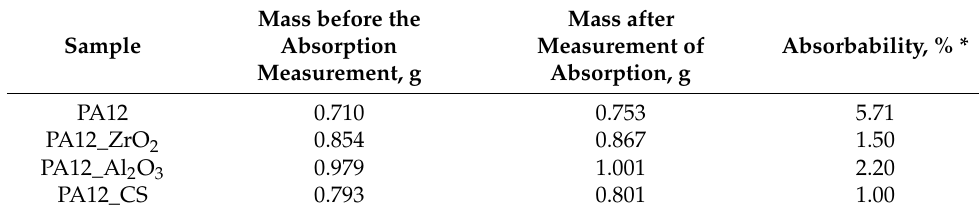
Table 10. Results of soaking